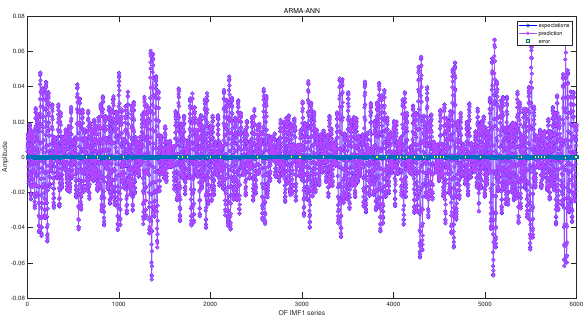
Figure 9. Prediction result of ARMA-ANN model for OF IMF1 time series.